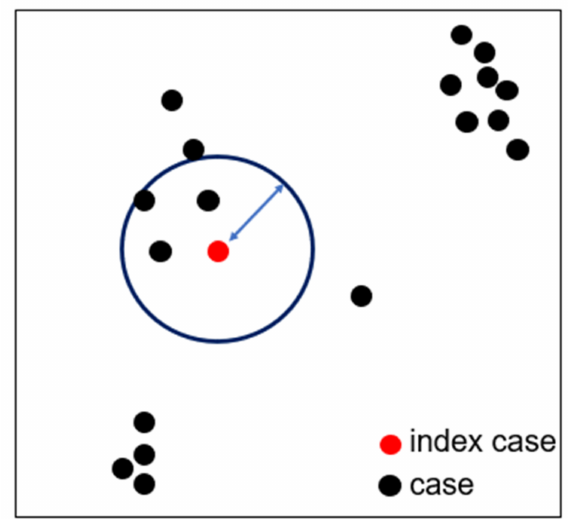
Figure 3. Cluster